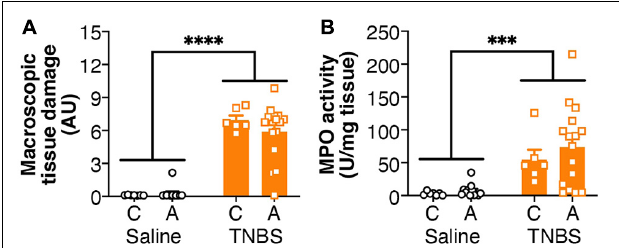
FIGURE 1 | Colitis is not altered by FAAH genotype. Colitis significantly increased (A) macroscopic tissue damage and (B) MPO activity, but there was no effect of genotype, or interaction between the genotype and colitis. n = 6–16/group. ∗∗∗ p < 0.001, ∗∗∗∗ p < 0.0001, main effect of colitis. Saline = left pair, black bars with circles. TNBS = right pair, orange bars with squares. In each pair, the left bar is the C allele group (CC genotype) and the right bar is the A allele group (AC/AA genotypes).